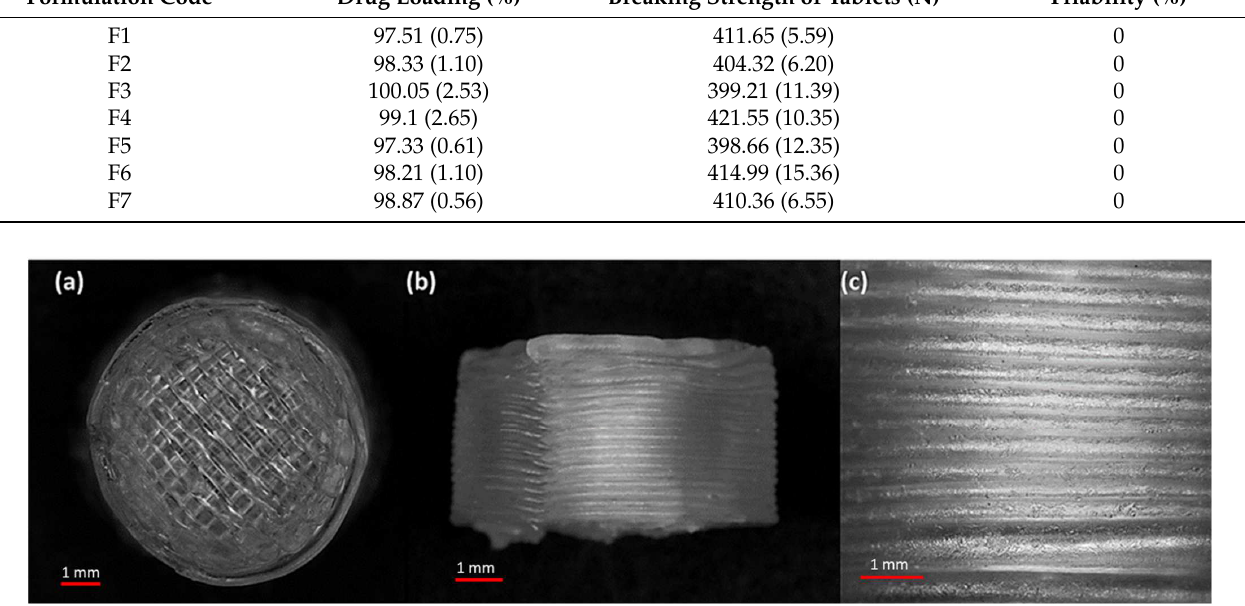
Figure 5. SEM micrographs of a 3D-printed tablet, namely F2 (2 shells with 0% infill): ( a ) whole matrix tablet; ( b ) side view of the matrix tablet; and ( c ) the side surface view.